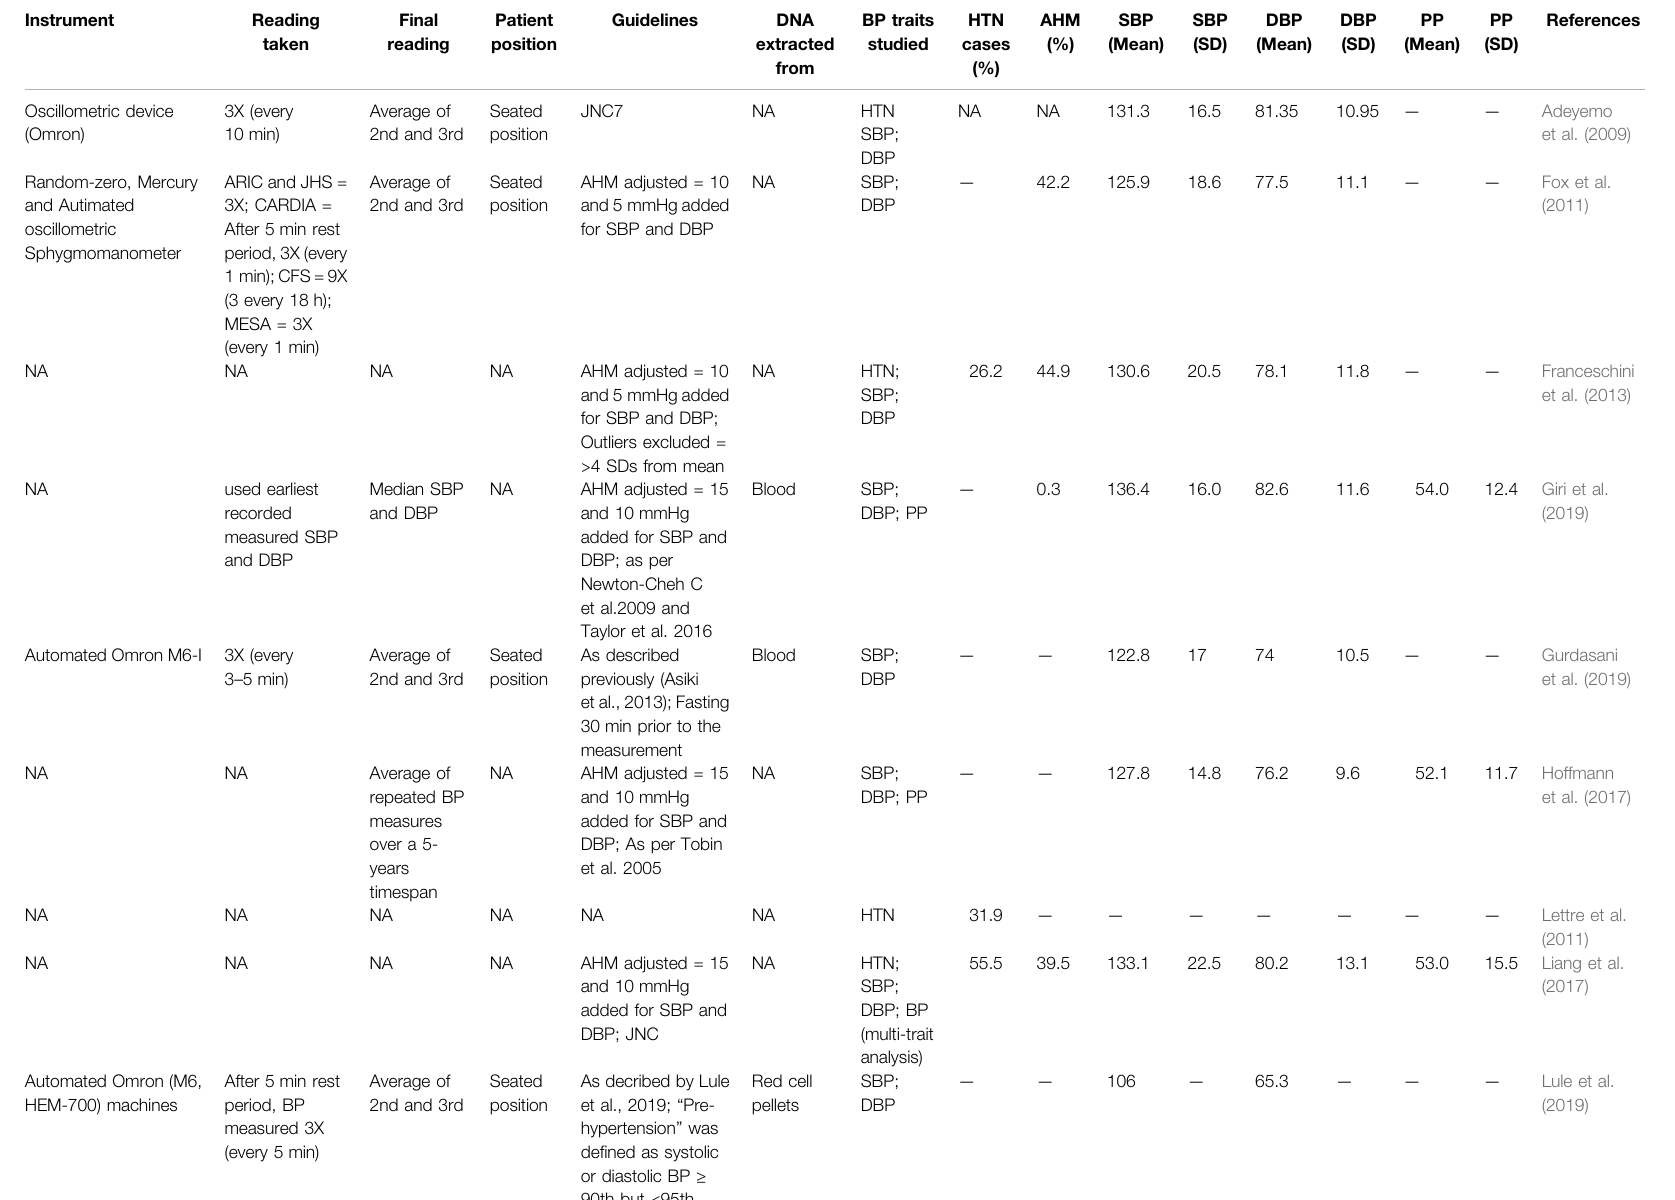
TABLE 2 | Phenotype characteristics (BP Traits and HTN) of the 12 eligible